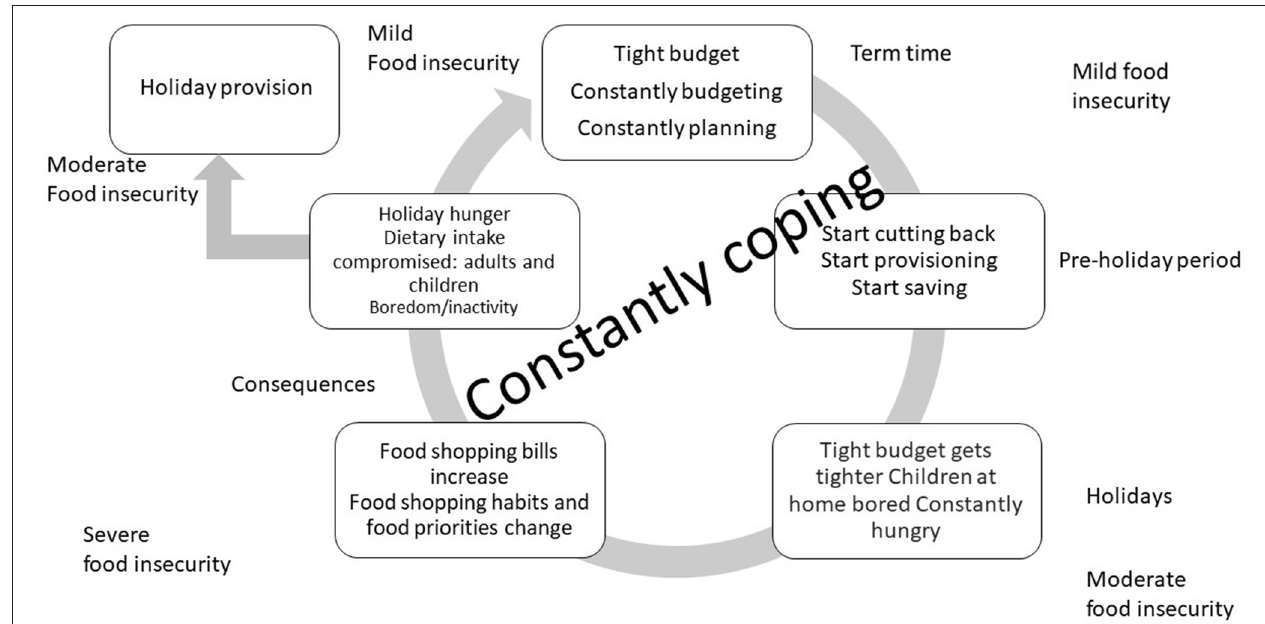
FIGURE 1 | A model of how parents and carers of child holiday club attendees food insecurity experiences change during the school academic year and school summer holiday period, based on the FAO food insecurity continuum (27).